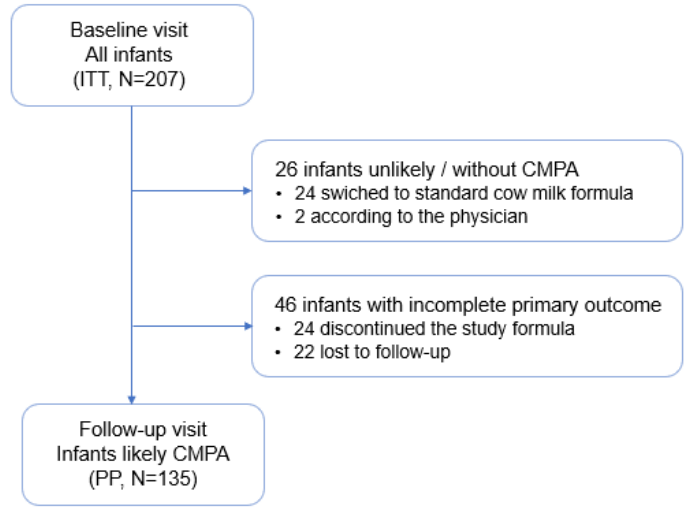
Figure 1. Patient flow diagram. ITT (intent to treat); PP (per protocol).